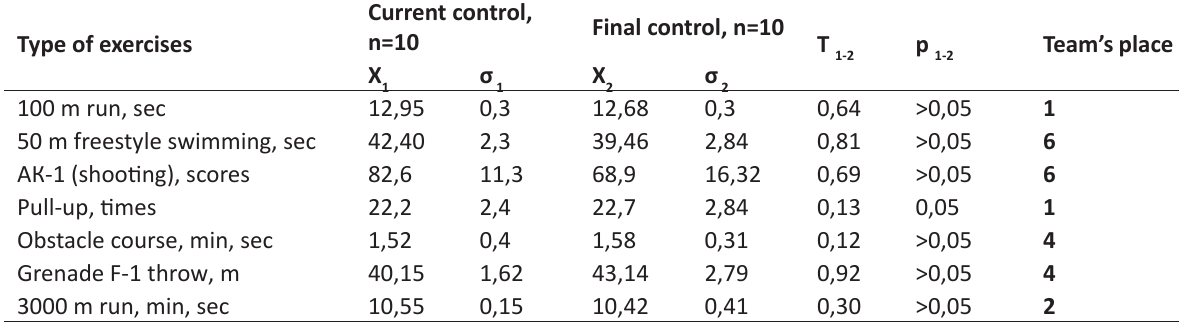
Table 3. Results of cadets’ preparation and performance in military applied heptathlon competitions Type of